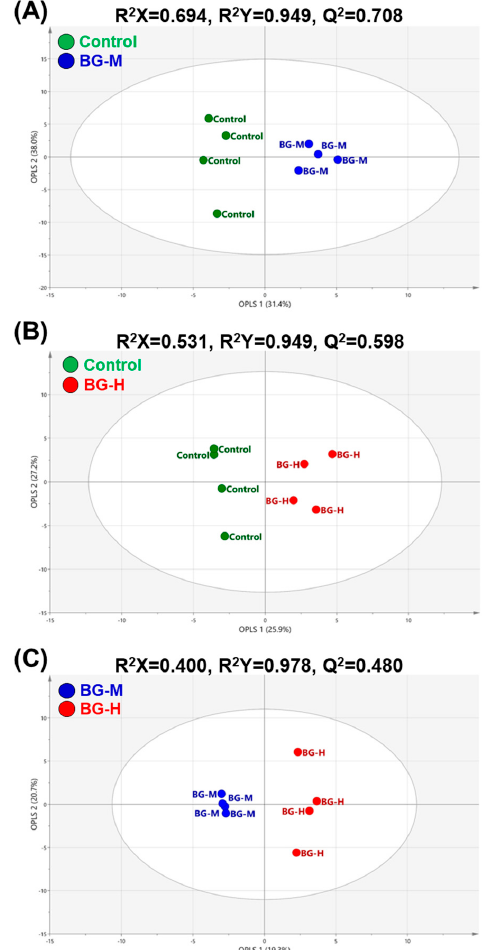
Figure 3. Score plots of the orthogonal partial least squares discriminant analysis (OPLS-DA) models obtained from 49 metabolites in the serum of beagle dogs fed on a control, BG-M, or BG-H diet for 8 weeks. OPLS-DA models indicate regressions between the control and BG-M ( A ), control and BG-H ( B ), or BG-M and BG-H ( C ) groups. Control, a regular diet; BG-M, regular diet with a medium concentration of BG extract; BG-H, regular diet with a high concentration of BG